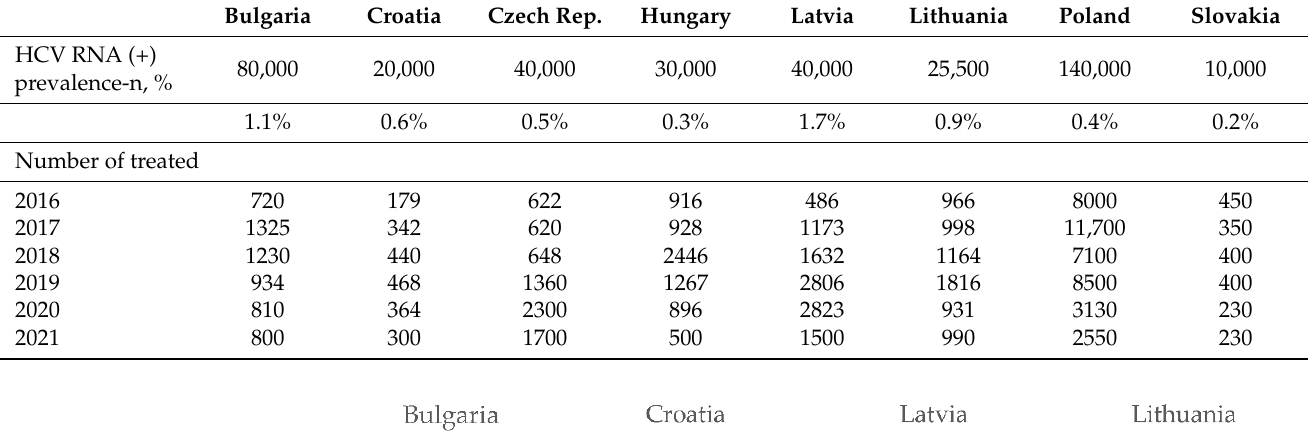
Table 1. Current HCV RNA prevalence and number of those treated in years 2016–2021 in selected Central European countries according to data provided by national experts.